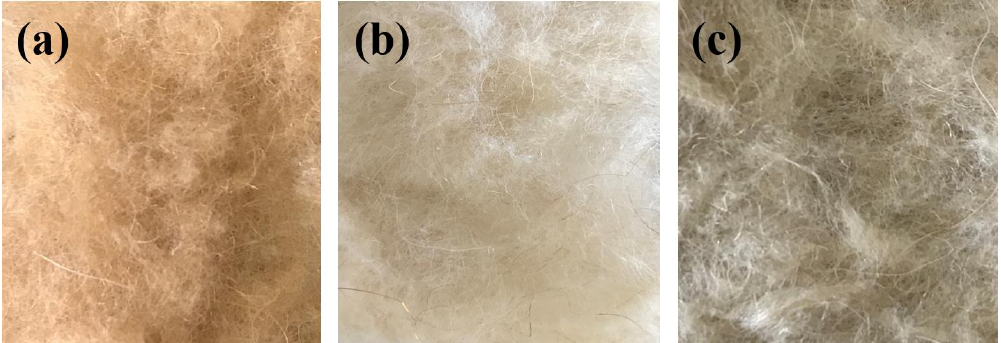
Figure 3. Photographs of control sample ( a ) and samples bleached in the ethanol–water ( b ) and water systems ( c ). Table 1. Degree of whiteness and weight loss of camel hair bleached in the ethanol–water and water systems.